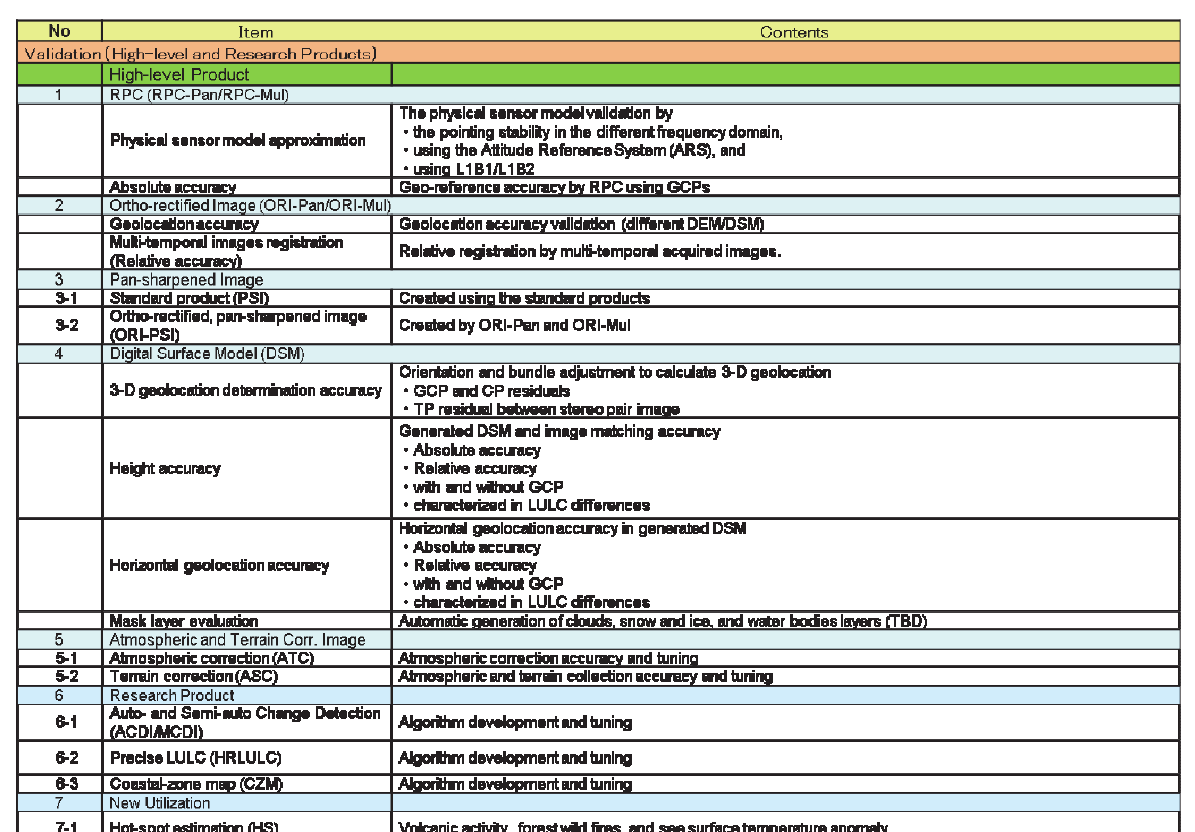
Table 4. Planned calibration items for ALOS-3 standard products